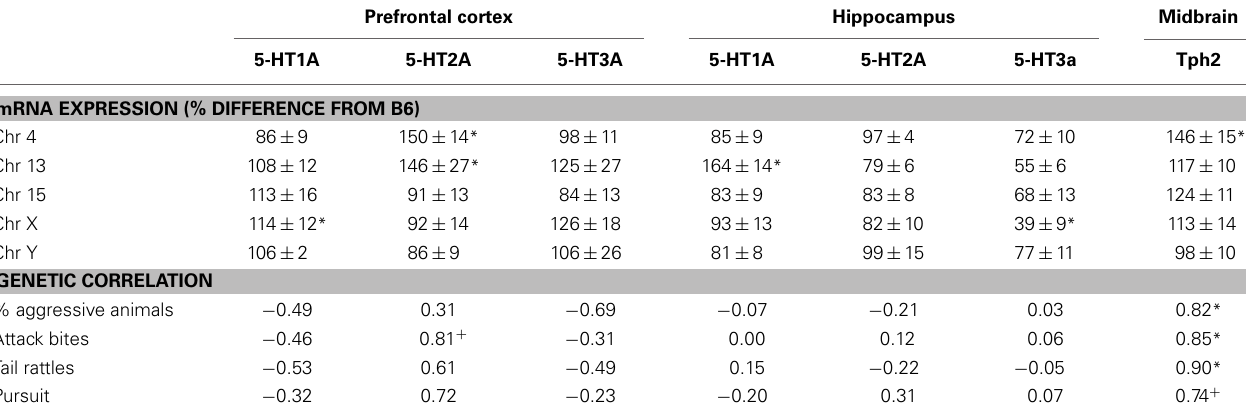
Table 4 | The expression of 5-HT receptors and Tph2 mRNAs in five consomic strains and their genetic correlations with aggressive behaviors. Prefrontal cortex